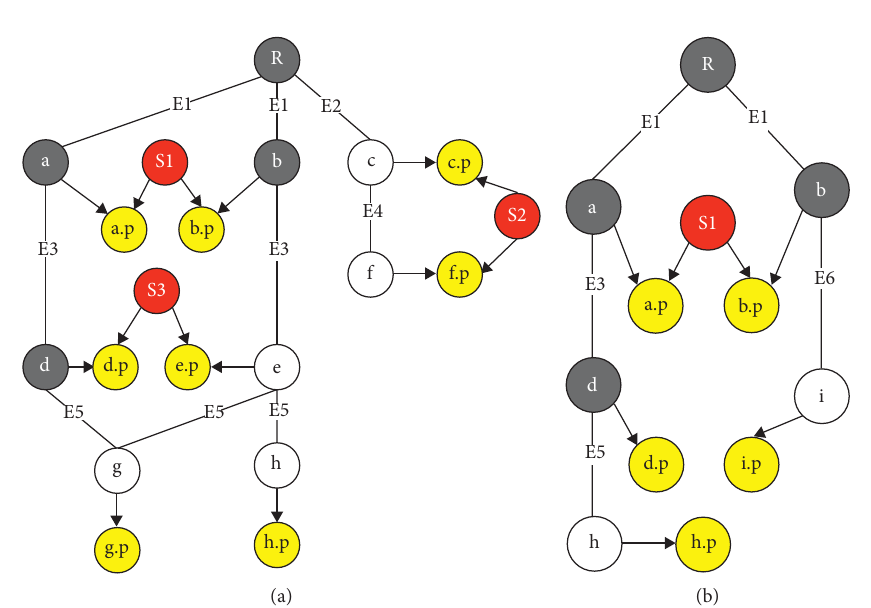
Figure 10: Mining flow chart.